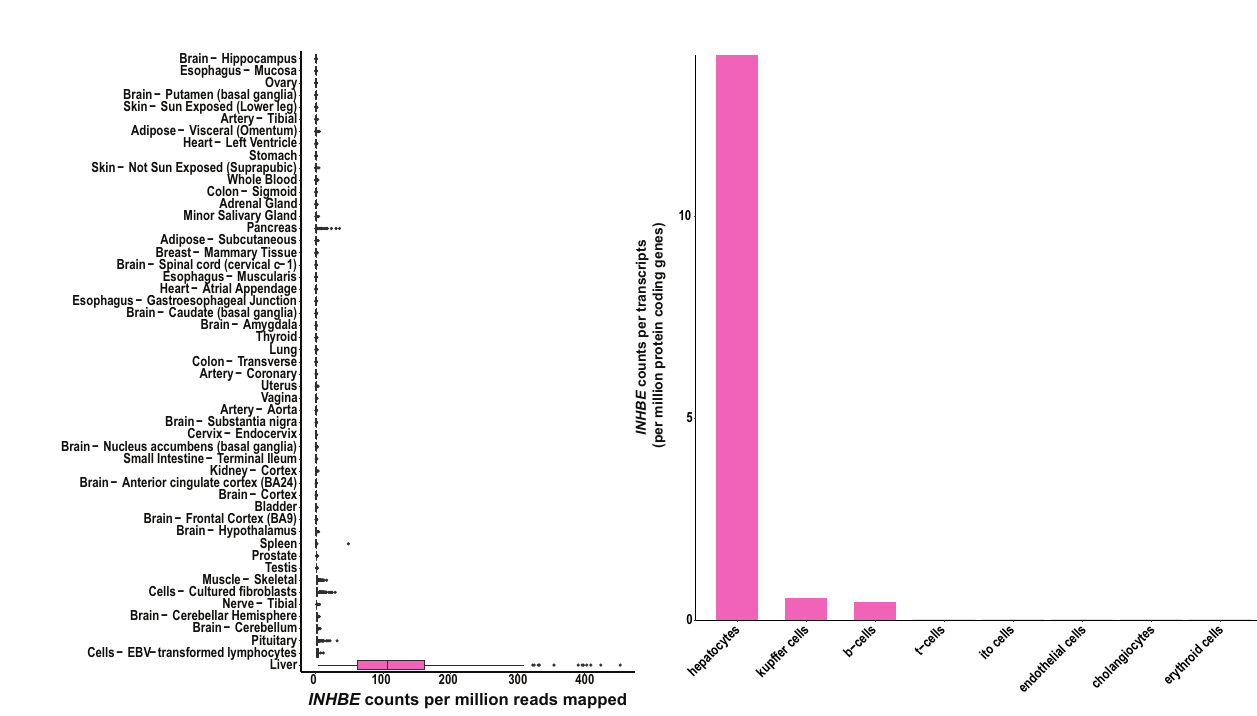
Fig. 3 | Protein-truncating variants in INHBE associated with favorable fat dis- tribution. Thetoppanelisalinearmodelofthe INHBE proteinwithprodomainand mature domains in gray and brown, respectively. An exon track shows the two exons of the gene (in purple and blue). Predicted loss of function (pLOF) variants identi fi ed by exome-sequencing and included in the gene-burden analysis are shown below the exon track, with numbers in parenthesis corresponding to the number of carriers for each allele. The bottom panel shows associations with fat distributionforpLOFvariantsin INHBE acrosscohorts.P-valuesarefromtwo-sided Wald tests. Markers represent the beta estimates while error bars represent 95%